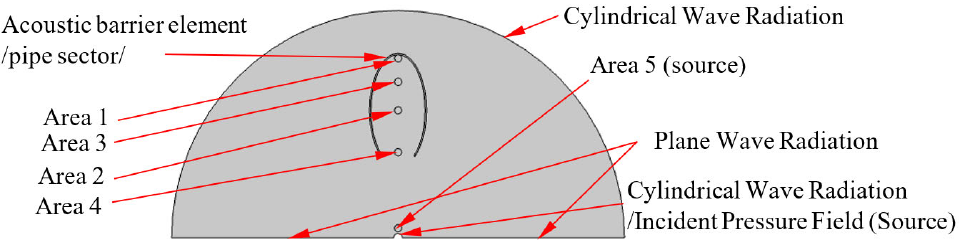
3 Table 1. COMSOL Model Parameters. Parameter